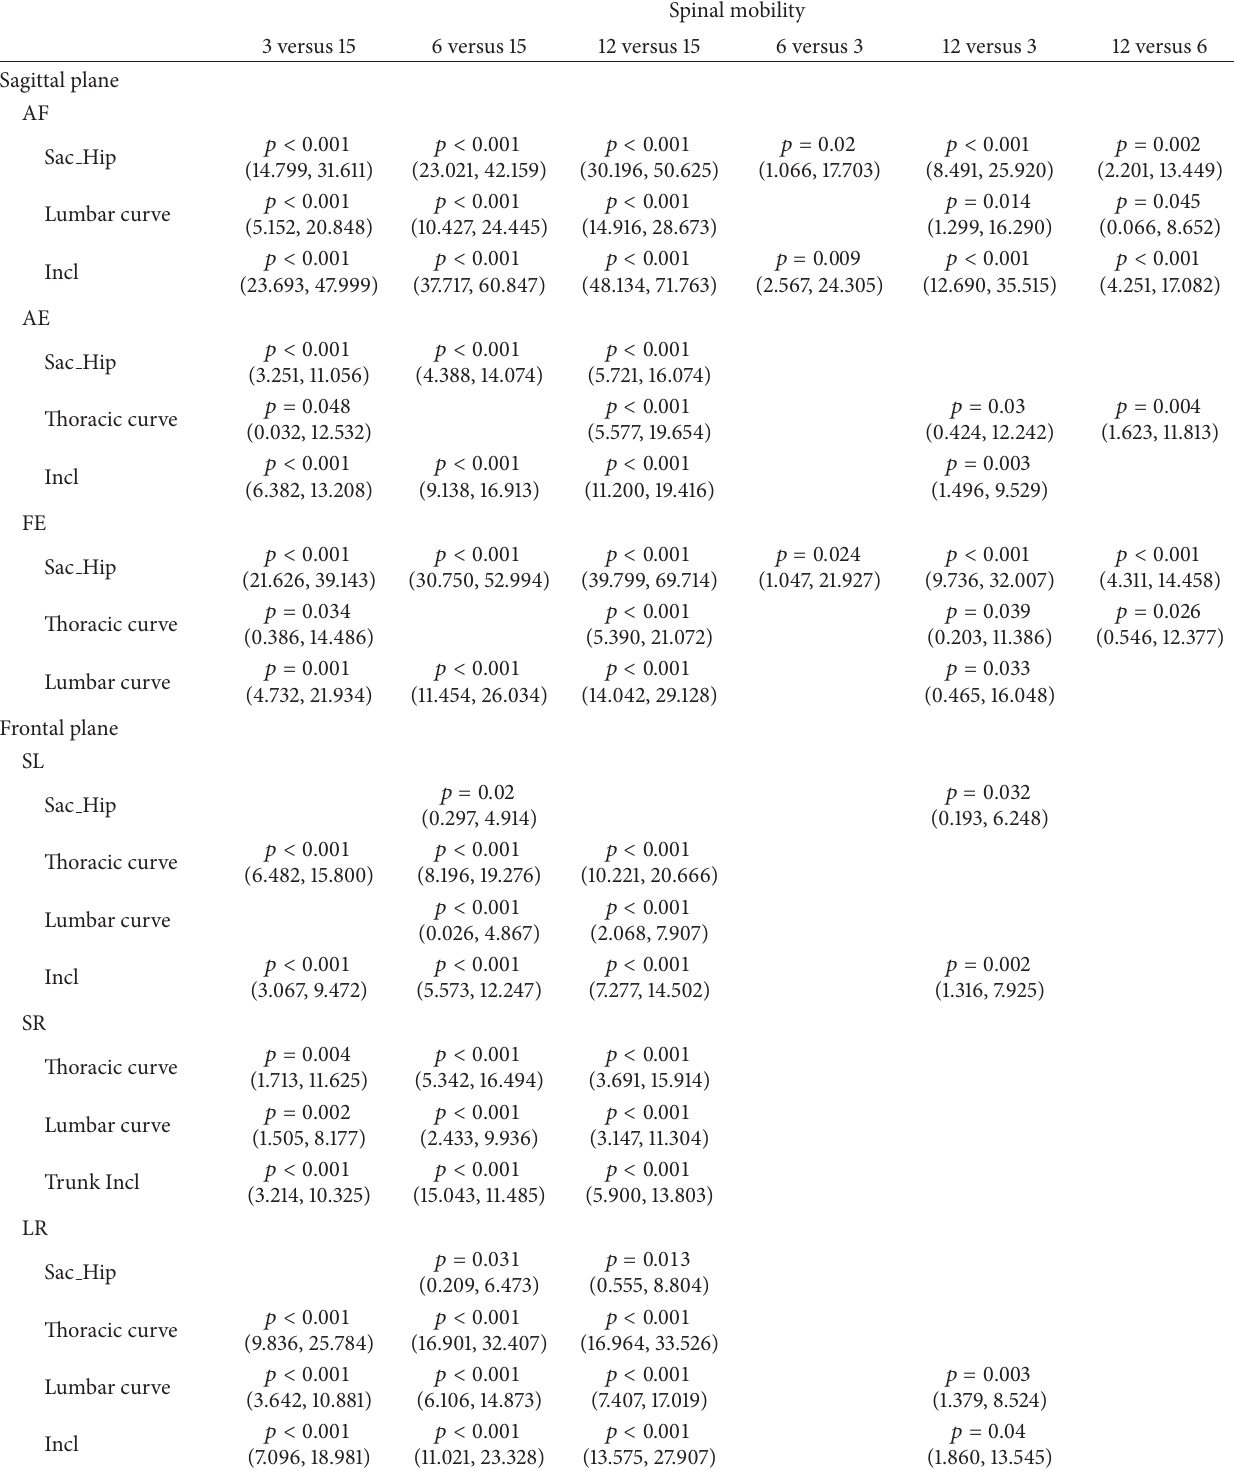
Table 3: Statistically significant changes in the mobility of the spine in the sagittal and frontal plane among reevaluations. Spinal mobility 3 versus 15 6 versus 15 12 versus